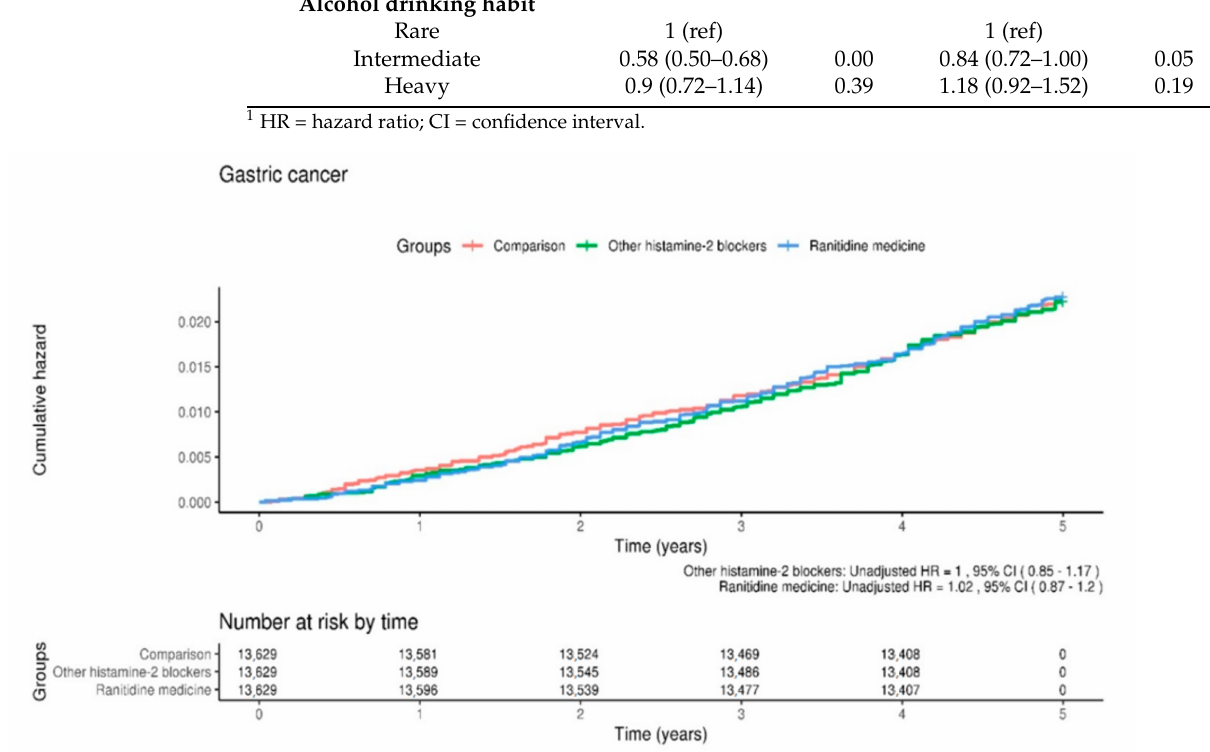
Figure 1. Kaplan–Meier survival curves and log-rank tests for the development of gastric cancer in the three study groups: control, other histamine-2 blockers, and